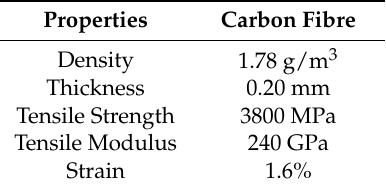
Table 2. Properties of carbon fibre supplied by Spinteks Tekstil Ins.